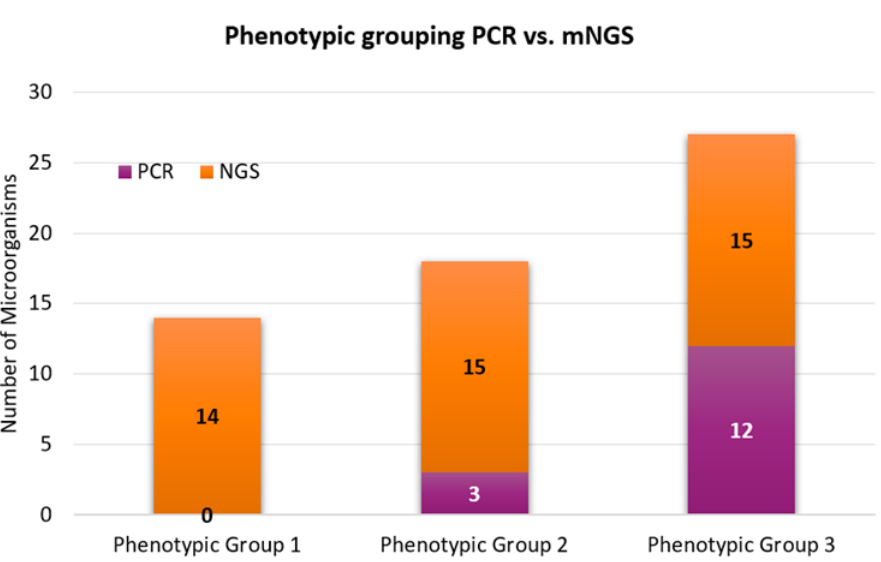
Figure 2. Comparative analysis of phenotypic grouping (PCR vs. mNGS; n = 29). To avoid any errors during position changes, please provide the combined image instead of editable pieces in the figure.